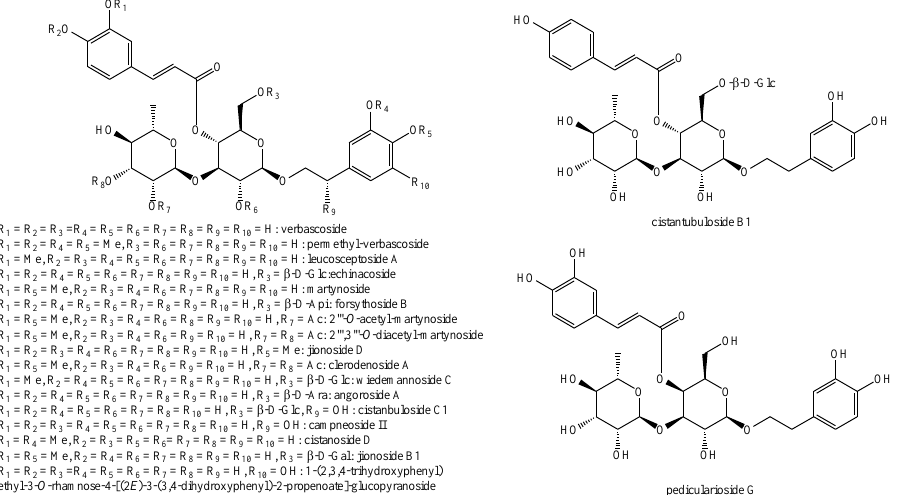
Figure 10. Phenylethanoid glycosides identified in Pedicularis species—part 1.